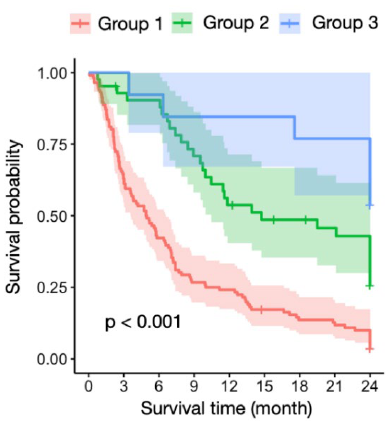
Figure A1. Survival curves of groups 1, 2, and 3 Red, green, and blue line presents survival curve of groups 1, 2, and 3, respectively. The area with lighter color represents the 95% confidence interval. Group 1 comprises patients with a RTS less than 9 points. Group 2 comprises patients with a RTS between 9 and 11 points. Group 3 comprises patients with a RTS more than 11 points. Abbreviation: RTS = revised Tokuhashi